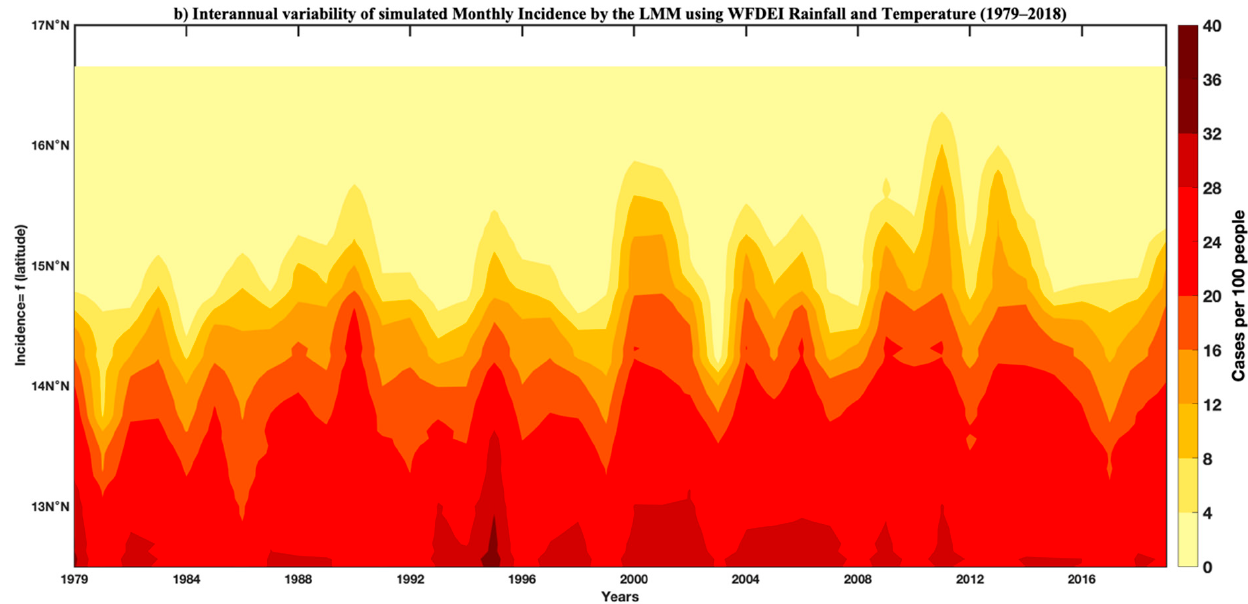
Figure 11. Hovmöller diagram of malaria incidence for the period 1979–2018: LMM model simula- tions based on WFDEI data: ( a ) annual variability and ( b ) interannual variability.